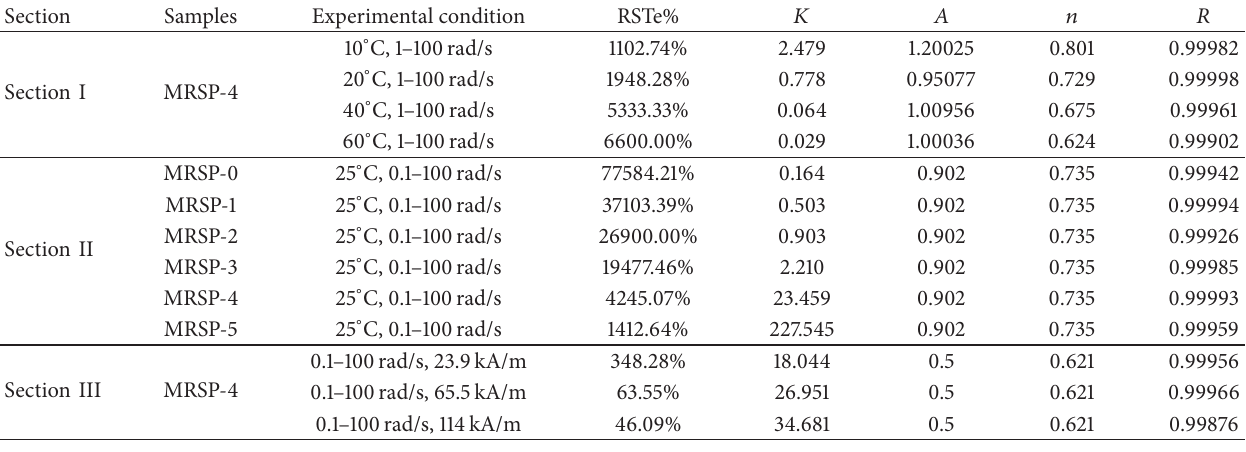
Table 4: All the fitting values of parameters.